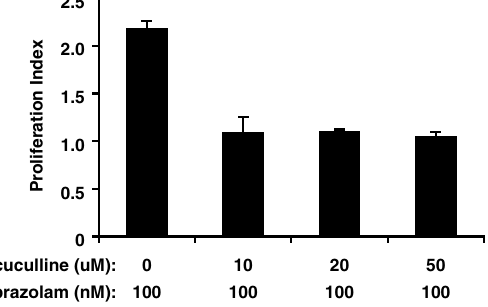
Figure 4. Treatment with bicuculline ablates the ability of alprazolam to enhance islet cell replication. Human islets were incubated with alprazolam (100 nM) together with a standard dose range of bicuculline (0–50 uM). Data shown are the average rate of proliferation relative to that of cultures with medium alone (designated as 1).